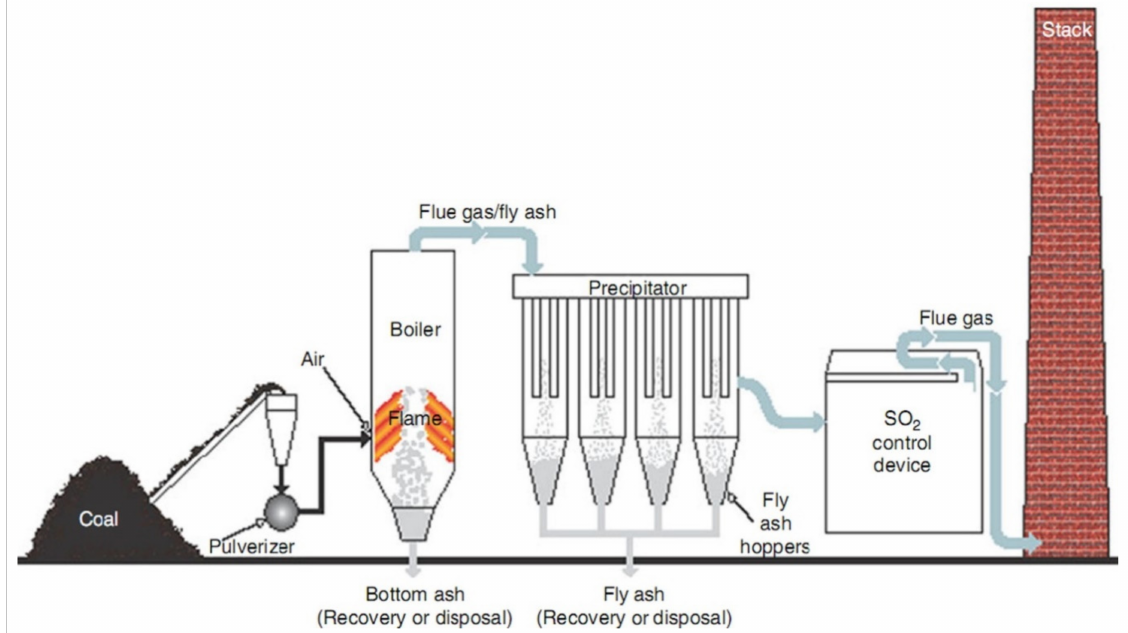
Figure 6. A schematic depiction of a clean production process of fly ash from coal. Reprinted with permission from Ref. [41]. Copyright 2021, with permission from